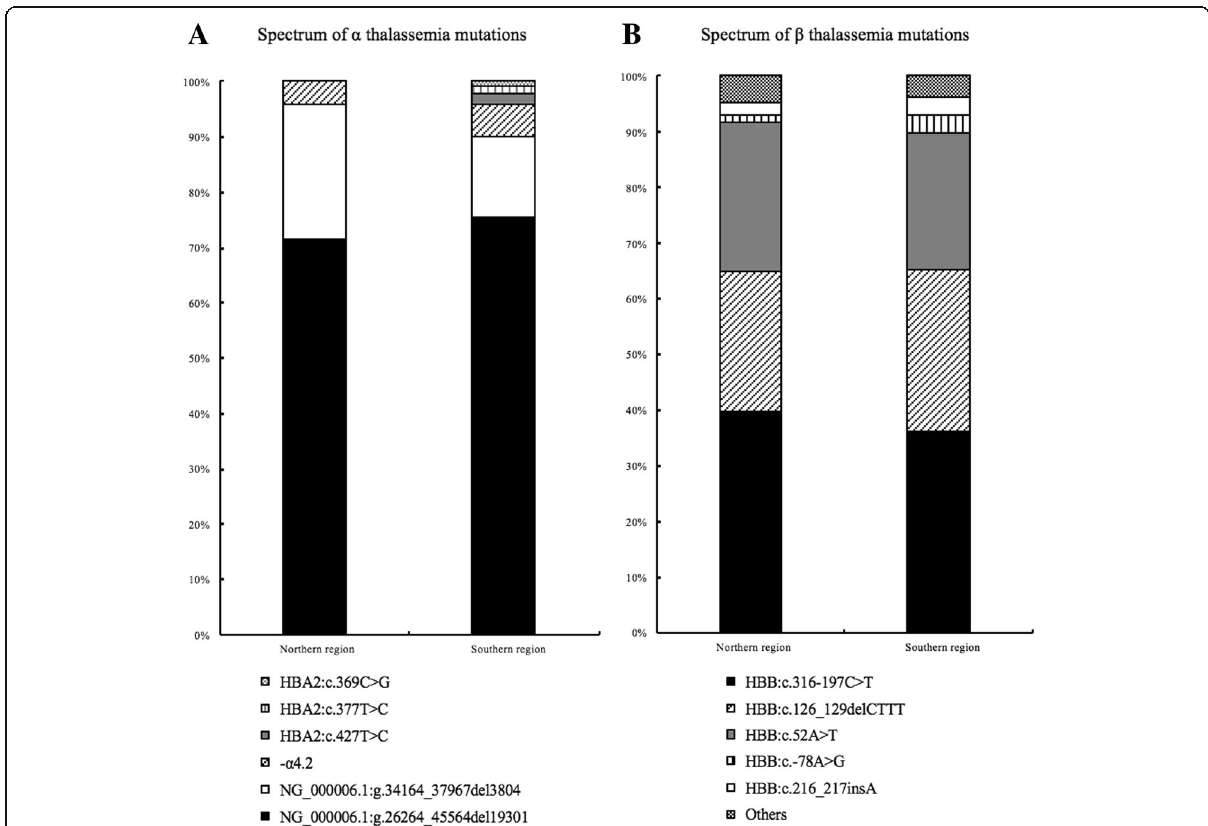
Fig. 1 Spectrum of α and β thalassemia mutations in Northern population origin from Southern and Northern region.( a ) Frequency of 6 most common α mutations composed the columns, spectrum of α thalassemia mutations origin from southern and northern area is present separately. ( b ) Frequency of 6 most common β mutations composed the columns, spectrum of β thalassemia mutations origin from southern and northern area is present separately. All precise value of each mutation are shown in Table 3 and Table